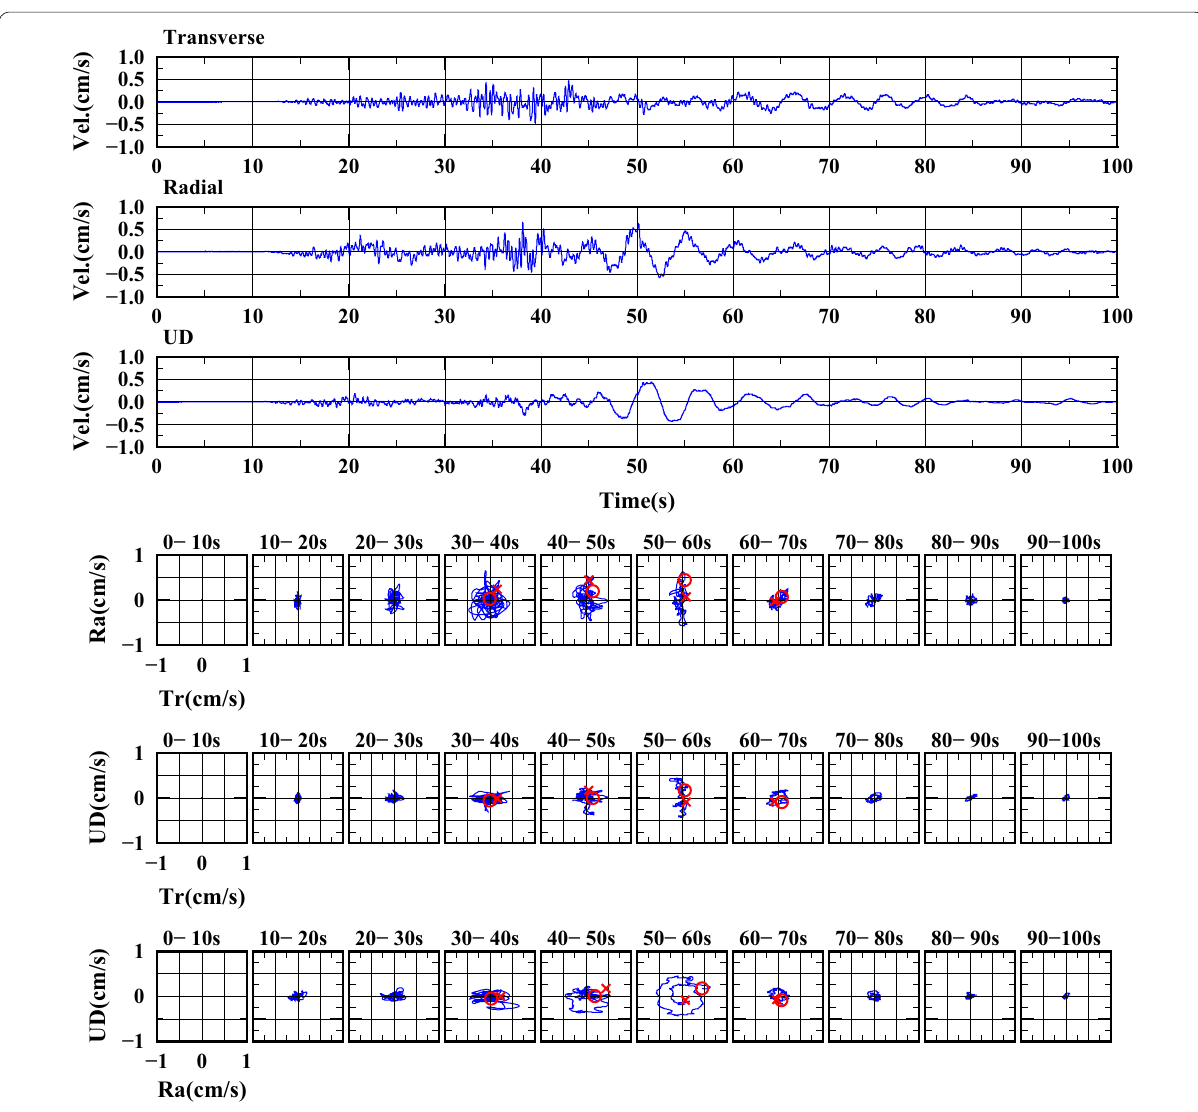
Fig. 8 Particle motion from velocity seismograms at station TKY003 during the 2011 event. The three bottom rows indicate the particle motions in the radial vertical (UD) plane, transverse vertical (UD) plane, and transverse radial horizontal plane . The particle motions are displayed every 10 s. Red circles and crosses indicate the start and end points, respectively. The three top figures are velocity traces in the transverse, radial, and UD compo- nents,